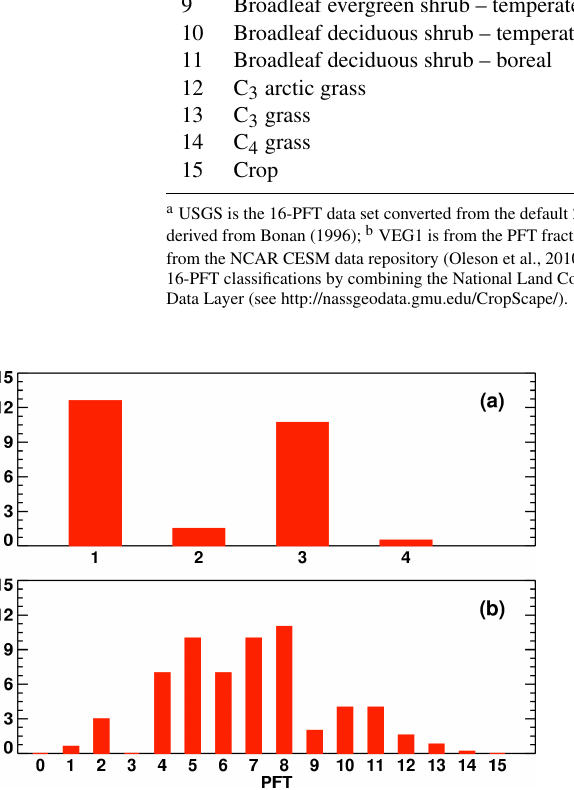
Figure 4. Biogenic isoprene emission factor for each PFT in (a) MEGAN v2.0, the PFT number 1–4 refers to broadleaf, needle- leaf, shrub, and herbs, respectively; (b) MEGAN v2.1, the PFT number 0–15 refers to the list in Table 1.